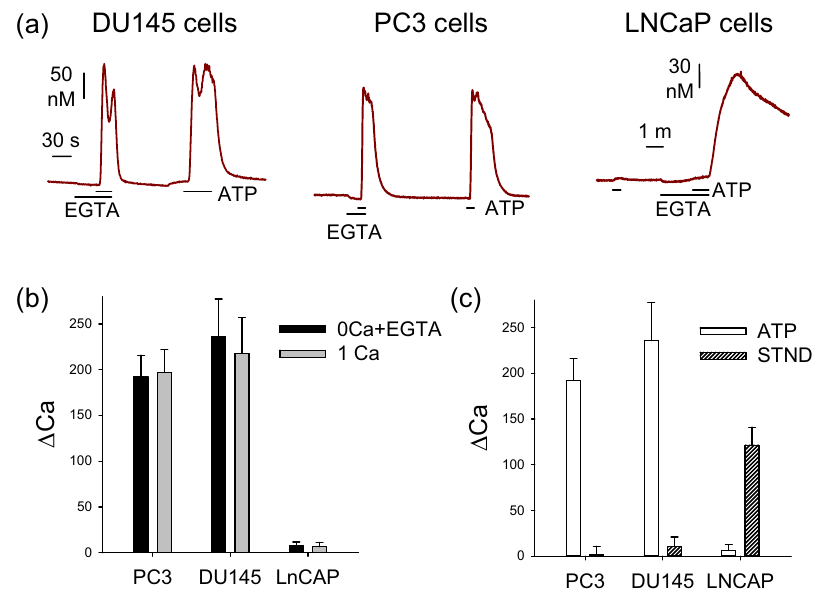
Figure 1: The e ff ect of ATP application on [ Ca 2 + ] i in PCa cells. ( a ) Internal [ Ca 2 + ] i spikes in Fura - 2 loaded DU145 and PC3 cells exposed to 10 µM ATP for 20 s in 0Ca - EGTA external solution ( EGTA ) and in basal ( 1 mM ) external Ca. The same protocol did not cause any [ Ca 2 + ] i rise in LNCaP cells, but [ Ca 2 + ] i increased when external Ca 2 + returned to the control value ( 1 mM ) . ( b ) Internal Ca 2 + level following 10 µM ATP application in the presence and absence of external Ca in the three cell lines, expressed as Δ Ca = [ Ca 2 + ] i ( ATP ) – [ Ca 2 + ] i ( basal ) . Lines represent SEM over the number of experiments, which were LNCaP n = 9, PC3 n = 7, DU145 n = 4. ( c ) [ Ca 2 + ] i level following ATP application in 0 Ca EGTA external solution in the three cell lines, as in B ( ATP ) , and after external Ca 2 + 1 mM was restored ( STND ) . Despite the low response to ATP, a SOCE response was always present in LNCaP cells, but not in the other two, ATP - respondent cell types. Number of experiments were LNCaP n = 7, PC3 n = 9, DU145 n = 4. Lines represent